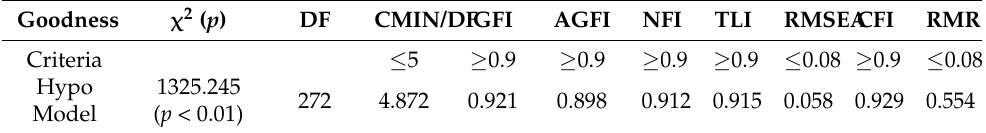
Table 3. Fitness statistics of confirmatory factor analysis model ( n =